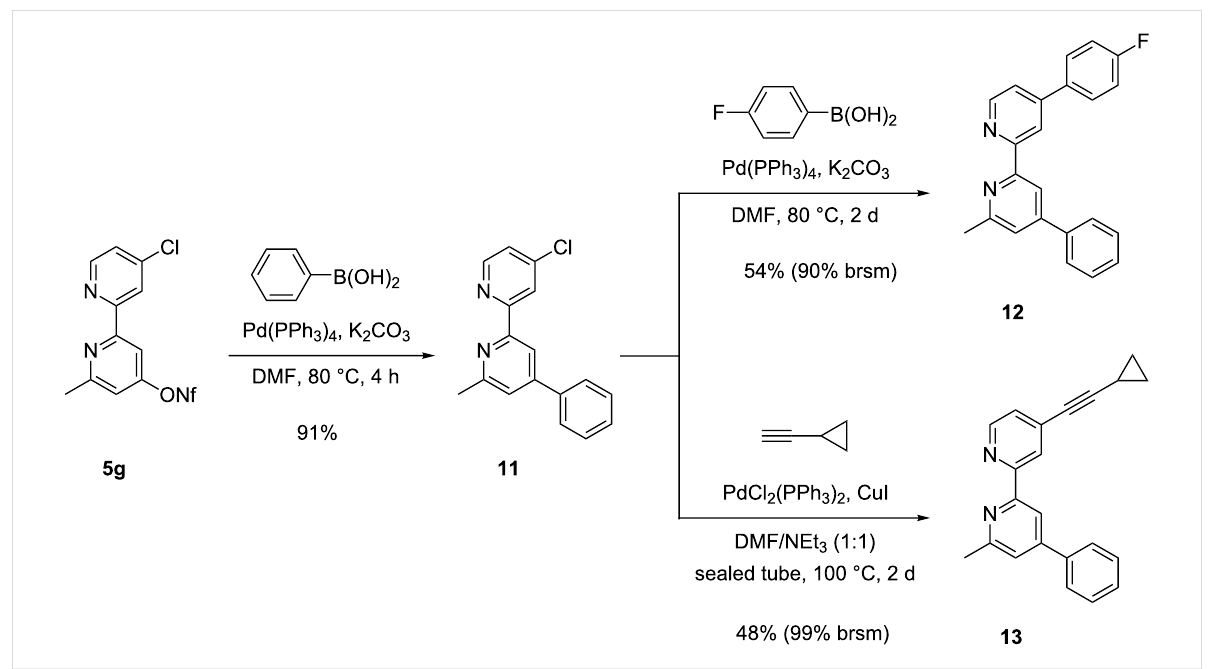
Scheme 6: Palladium-catalyzed couplings of chloro-substituted 2,2'-bipyrid-4-yl nonaflate 5g leading to compounds 11 , 12 and 13